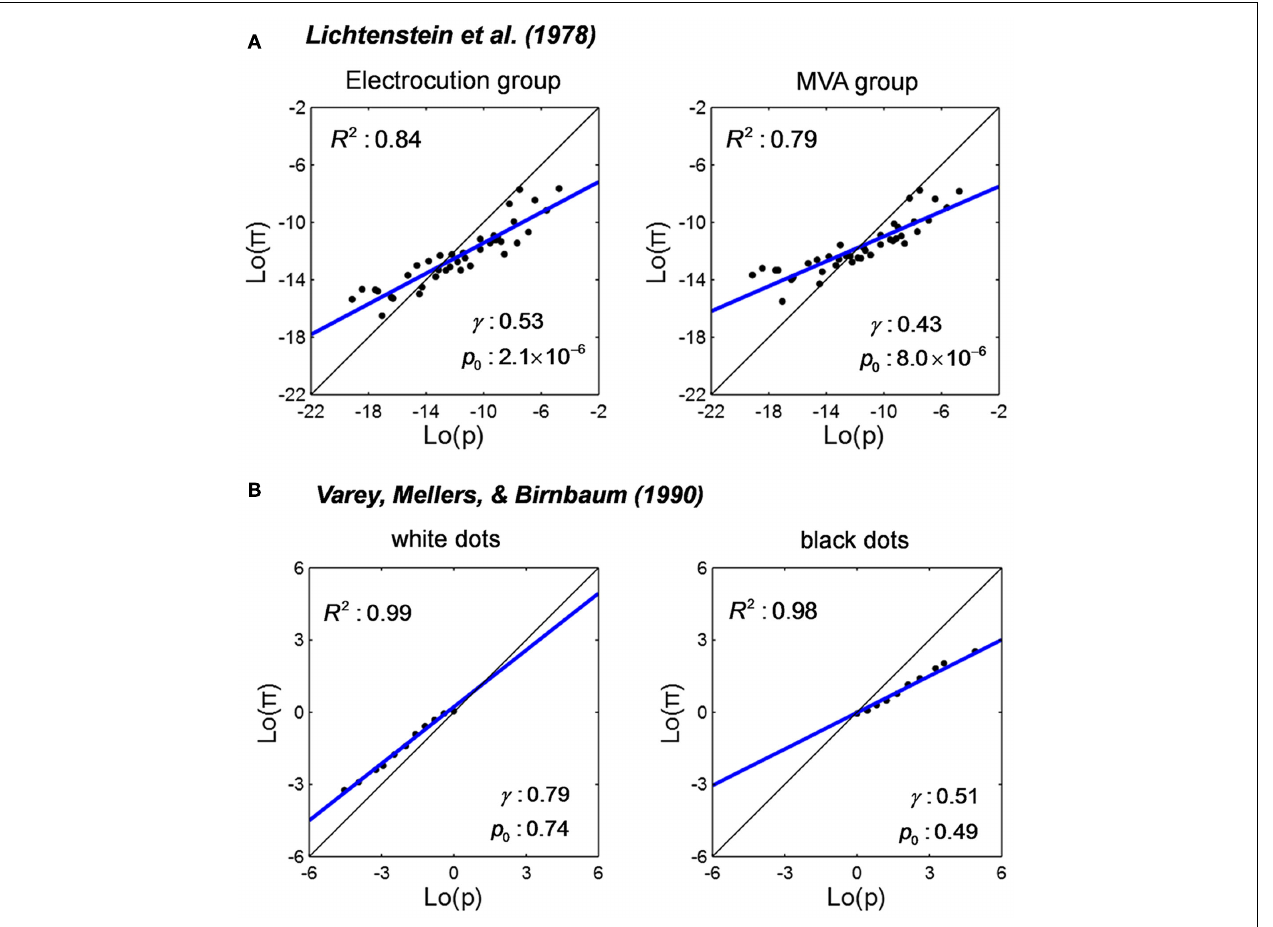
then US population. Left: when the frequency of Electrocution (1000) was given as reference. Right: when the frequency of MVA (motor vehicle accident, 50000) was given as reference. (B) Estimated frequency of visual stimuli fromVarey et al. (1990).The task was to estimate the relative frequency of black or white dots among a visual array of black and white dots.The proportion of black dots was larger than the proportion of white dots.Two groups of participants respectively estimated the relative frequency of white dots (small p ) and black dots (large p ). Left: the white dots group ( p ≤ 0.5) was estimated. Right: the black dots group ( p ≥ 0.5) was